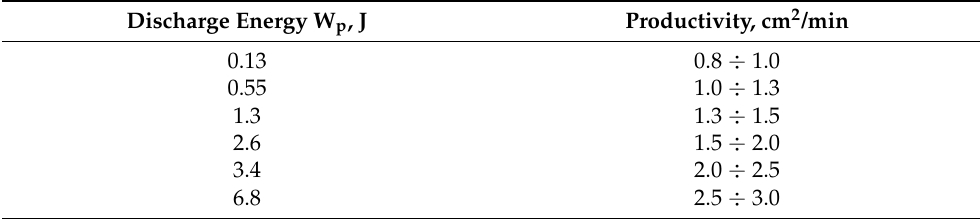
Table 1. Dependence of ESA productivity on discharge